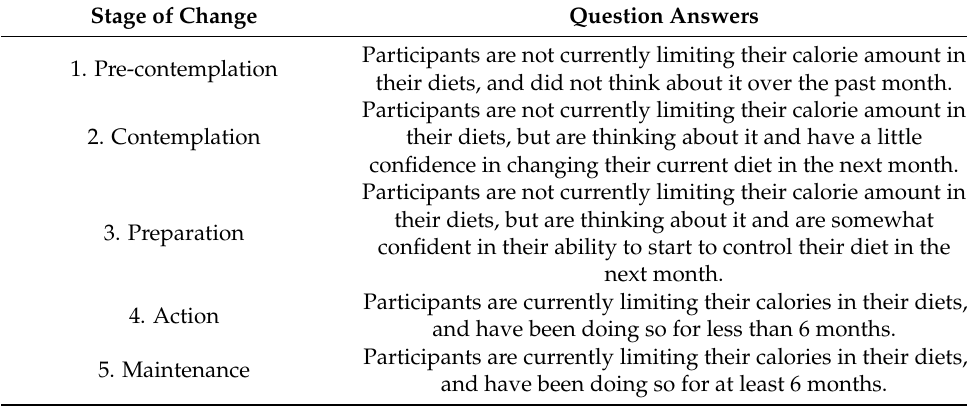
Table 1. Staging algorithm scoring (after Curry et al.,